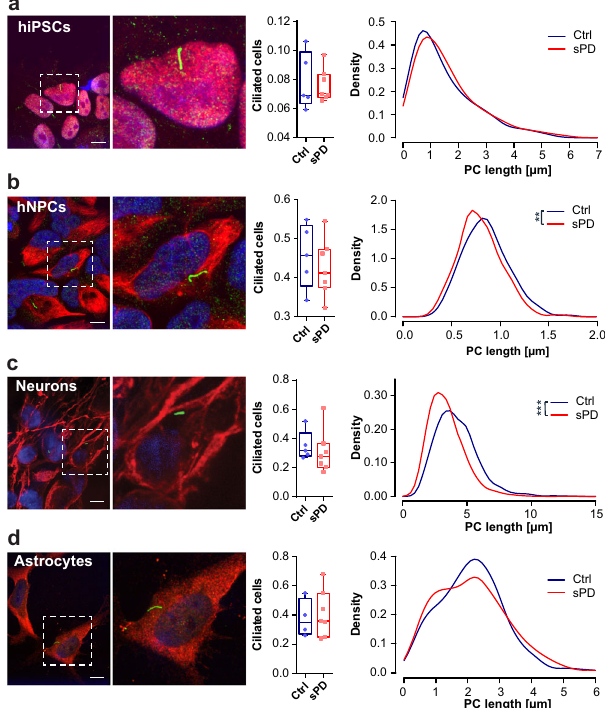
Fig. 5 | Primary cilia morphology in sPD. a (right) Density plot illustrating the distribution of PC length (in µ m) in hiPSCs. (middle) Fraction of ciliated cells. PC length was measured in immunostainings (left) of hiPSCs positive for anti-SOX2 (red) and anti-ARL13B (green). n =37-79 cilia per clone. b (right) Density plot illustrating the distribution of PC length (in µ m) in hNPCs. (middle) Fraction of ciliated cells. PC length was measured in immunostainings (left) of hNPCs positive for anti-NES and anti-ARL13B. n =74-123 cilia per clone. c (right) Density plot illus- trating distribution of PC length (in µ m) in neurons. (middle) Fraction of ciliated cells. PC length was measured in immunostainings (left) of neurons positive for anti-TUBB3 (red) and anti-ARL13B (green). n =131-385 cilia per clone. d (right) Density plot illustrating distribution of PC length (in µ m) in astrocytes. (middle) Fraction of ciliated cells. PC length was measured in immunostainings (left) of astrocytes positive for anti-GFAP (red) and anti-ARL13B (green). n =100 cilia per clone. All experiments were performed in triplicates, n =5 Ctrl and 7 sPD. Immu- nostainingsareexemplarilyshownforG3G-R1-039withscalebars=10 µ m.Boxplots display the median and range from the 25th to 75th percentile. Whiskers extend from the min to max value. Each dot represents one patient. P -values were deter- mined by two-sided t -test a (middle), b (middle), c (middle), d (middle); two-sided Kolmogorov-Smirnov test (ks) + linear mixed effects model (lm) a (right - ks p =0.15;lm p =0.48), b (right-ks p =0.0007;lm p =0.04), c (right-ks p =2.2×10 − 16 ; lm p =0.009), d (right - ks p =0.31; lm p =0.94). # p <0.1, * p <0.05, ** p <0.01, *** p <0.001. Source data are provided as a Source Data fi